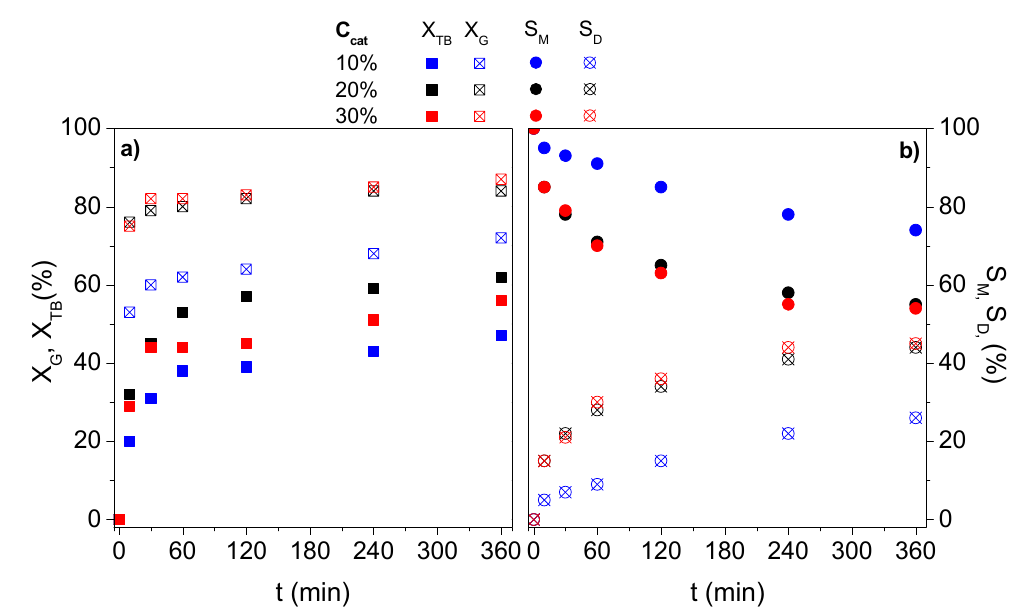
Figure 5. Influence of catalyst concentration on G and TB conversion ( a ) and M and D selectivity ( b ) with reaction time. Operating conditions: 70 °C, 4 bar, G:TB = 1:3, DBE:TB = 1:2 (R3, R1 and R4).